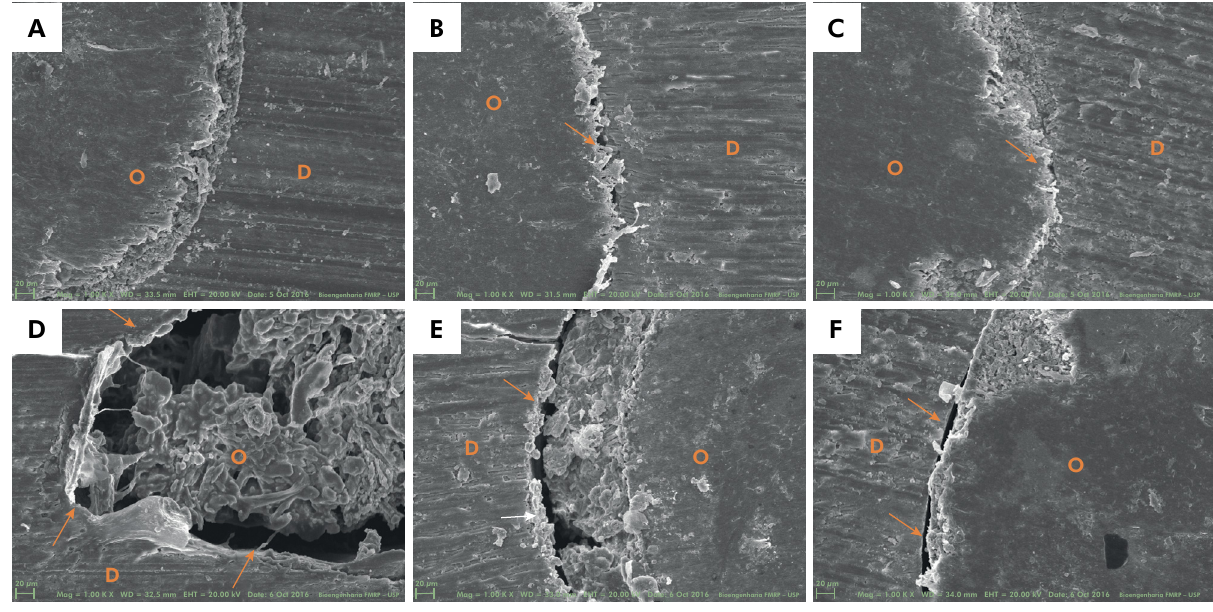
Figure 1. SEM micrographs obtained after the dehydration protocol, showing the sealer/dentin interface in non-irradiated and irradiated teeth, irrigated with (A) NaOCl, (B) EDTA, and (C) chitosan, and filled with the lateral condensation technique using AH Plus sealer (1000x). D: dentin; O: